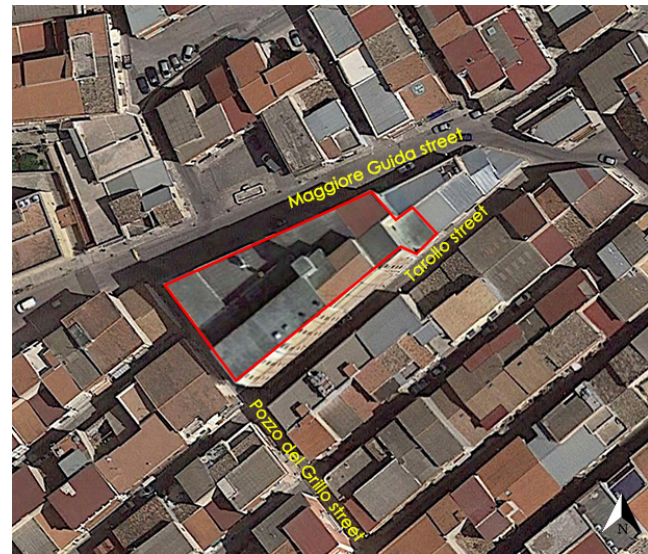
Figure 1. Site plan of Molino-Pastificio Soresi (today).